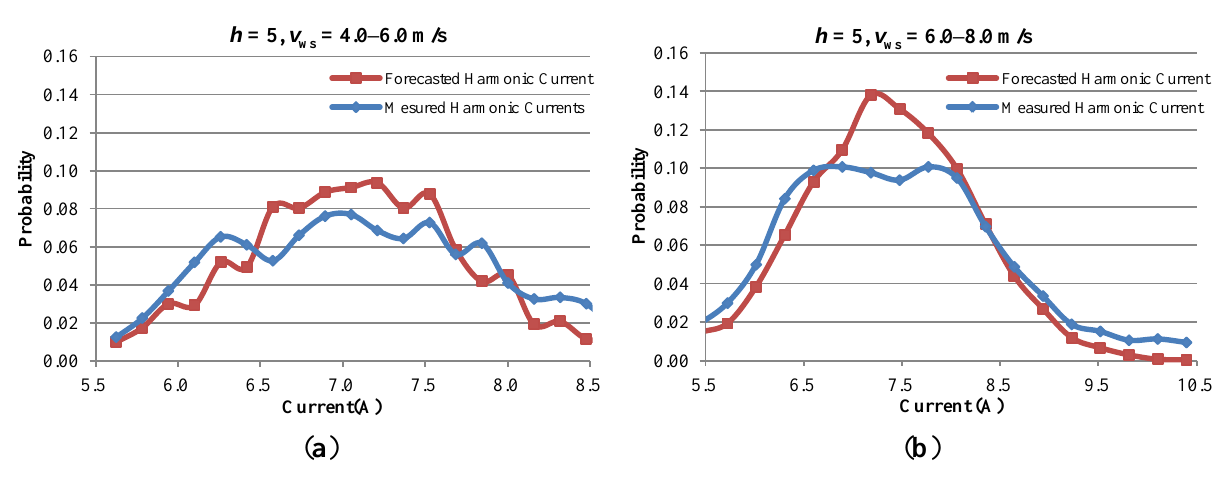
Figure 9. Measured and forecasted probability distributions of the 5th harmonic currents.